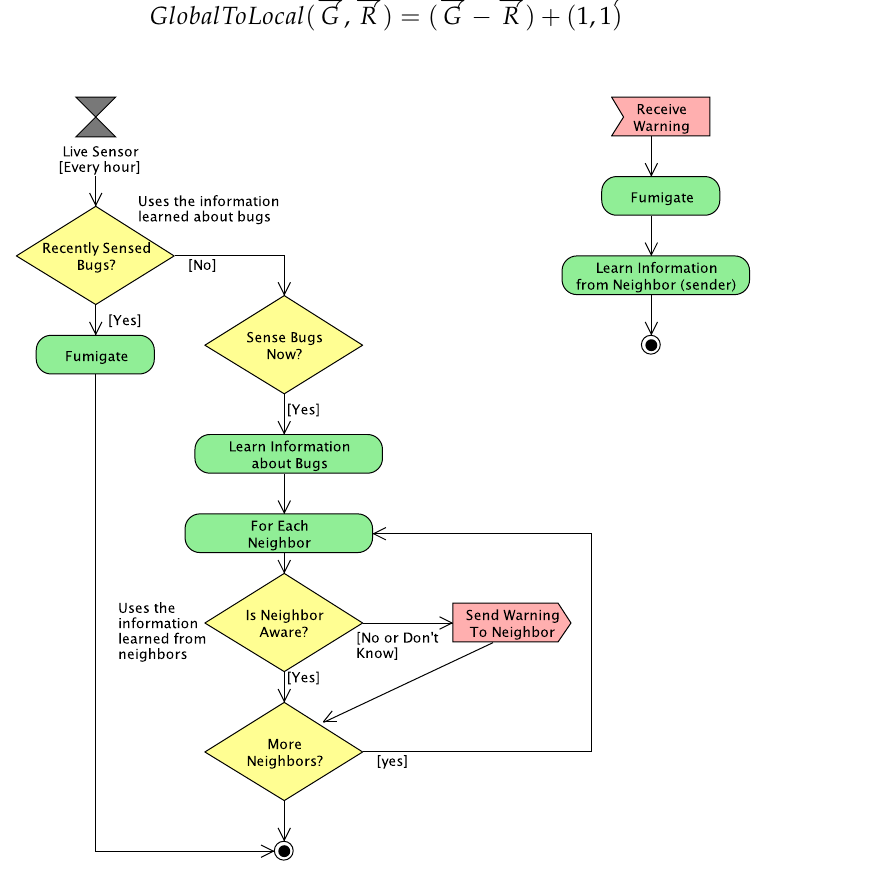
Figure 4. Functional block diagram of the smart low-cost neighbor